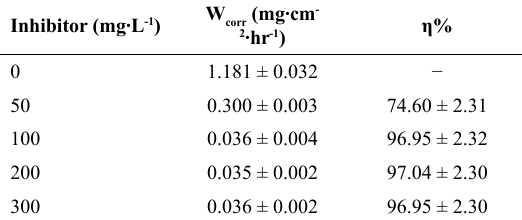
Table 4. C-steel weight loss data in 1.0 mol∙L -1 HCl with and without ethanolic Aniba canelilla stem extract at the following concentrations: 0, 50, 100, 200 and 300 mg∙L -1 .